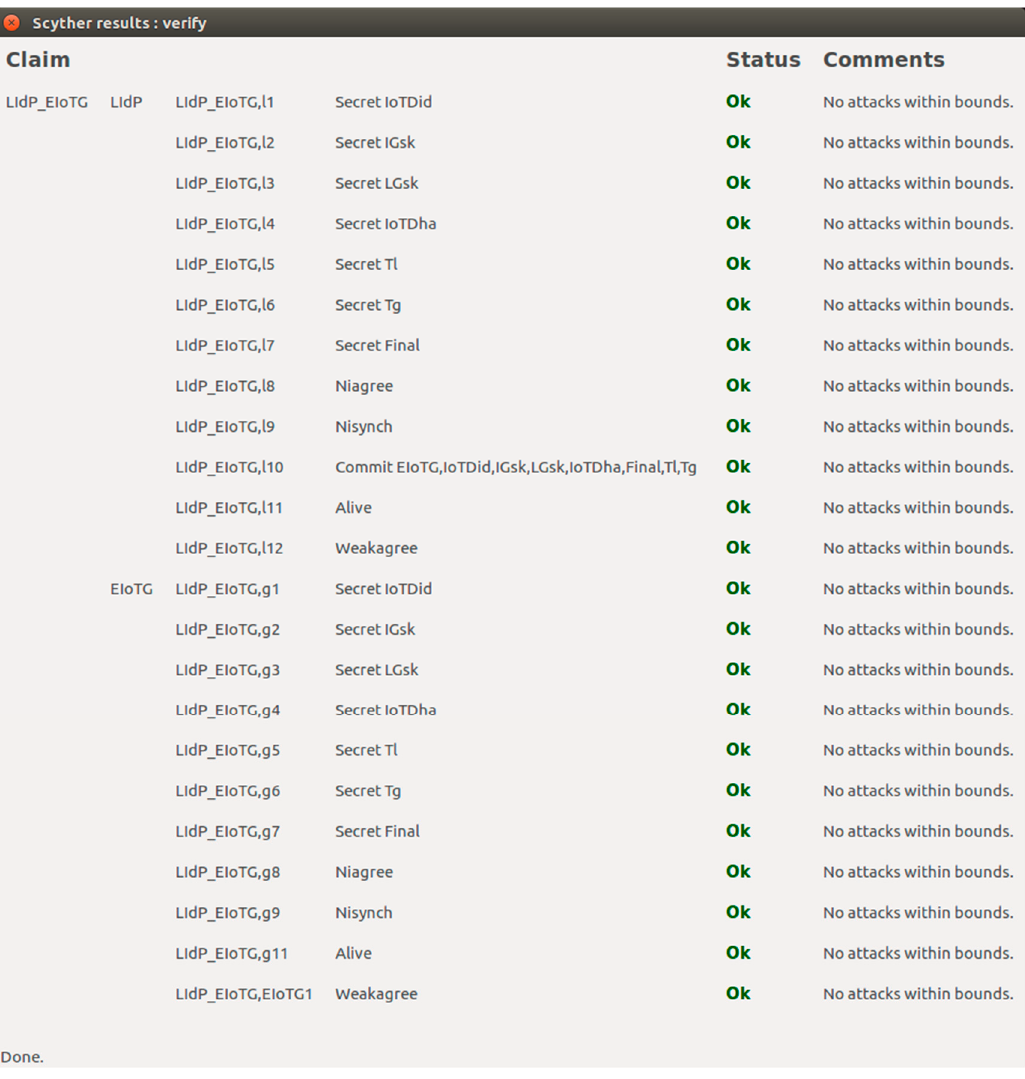
Figure 16. Identity parameters initialization between LIdP and EIoTG.